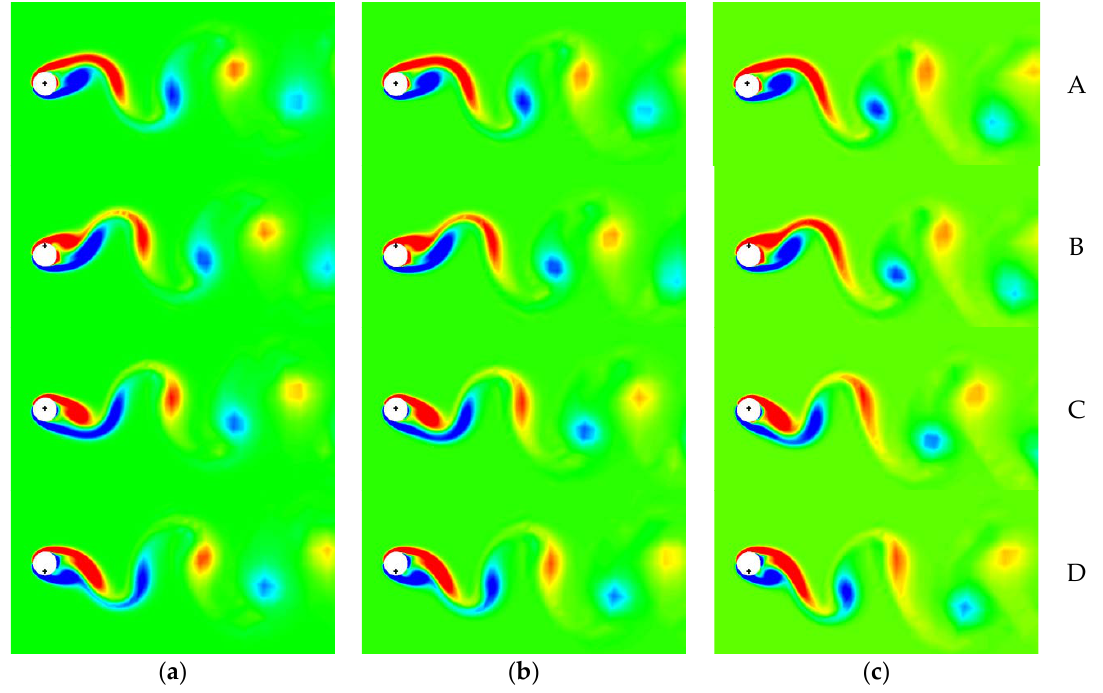
Figure 4. The periodical variation of flow field with different shear rate K where A, B, C and D represent the times at t = 0T/4, 1T/4, 2T/4 and 3T/4, respectively: ( a ) K = 0; ( b ) K = 0.1; and ( c ) K = 0.2.